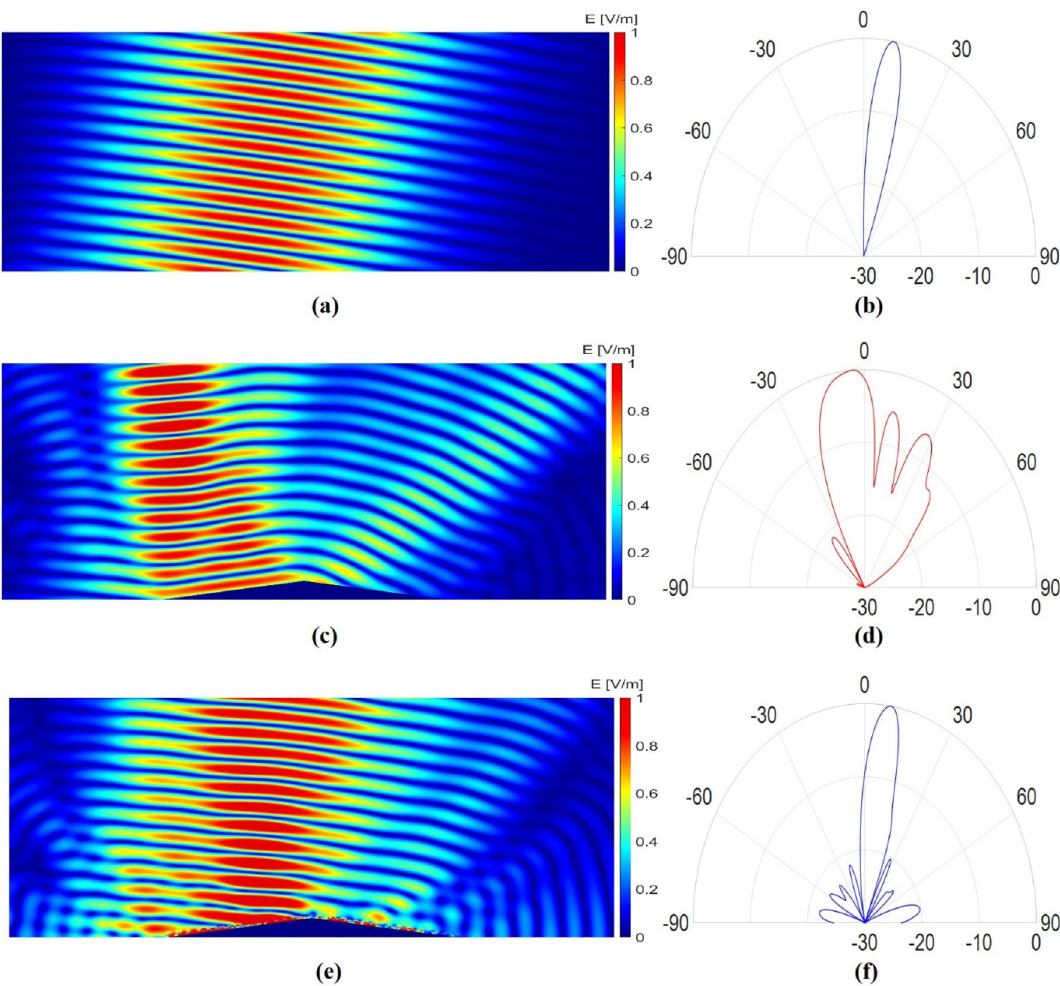
Figure 4. Simulation results for Gaussian wave incidence with the incident angle of 10°. ( a, c, e ) Near field reflected electric field distribution for a metallic ground plane, bare bump, and cloaked bump, respectively. ( b, d, f ) The normalized intensity of the scattered field (dB) for a metallic ground plane, bare bump, and cloaked bump,